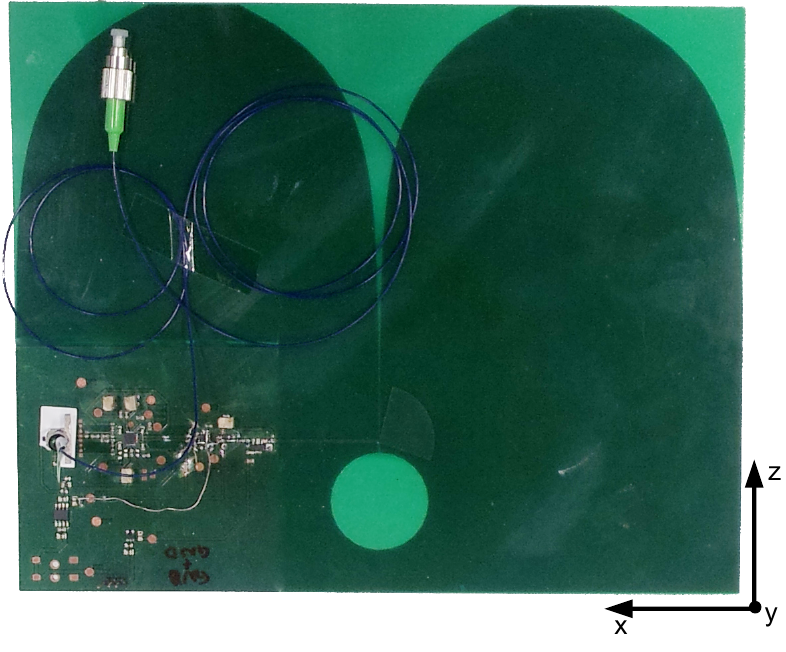
Figure 4. Back side of antenna with electronic circuit and radial